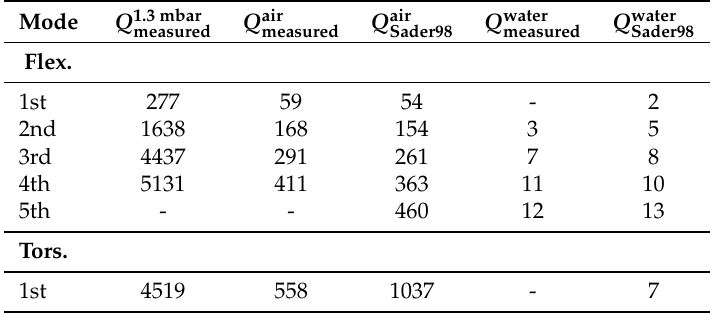
Table 4. Comparison between the experimentally measured and the theoretical flexural [19], and torsional [20], quality factors of the CONT cantilever in different